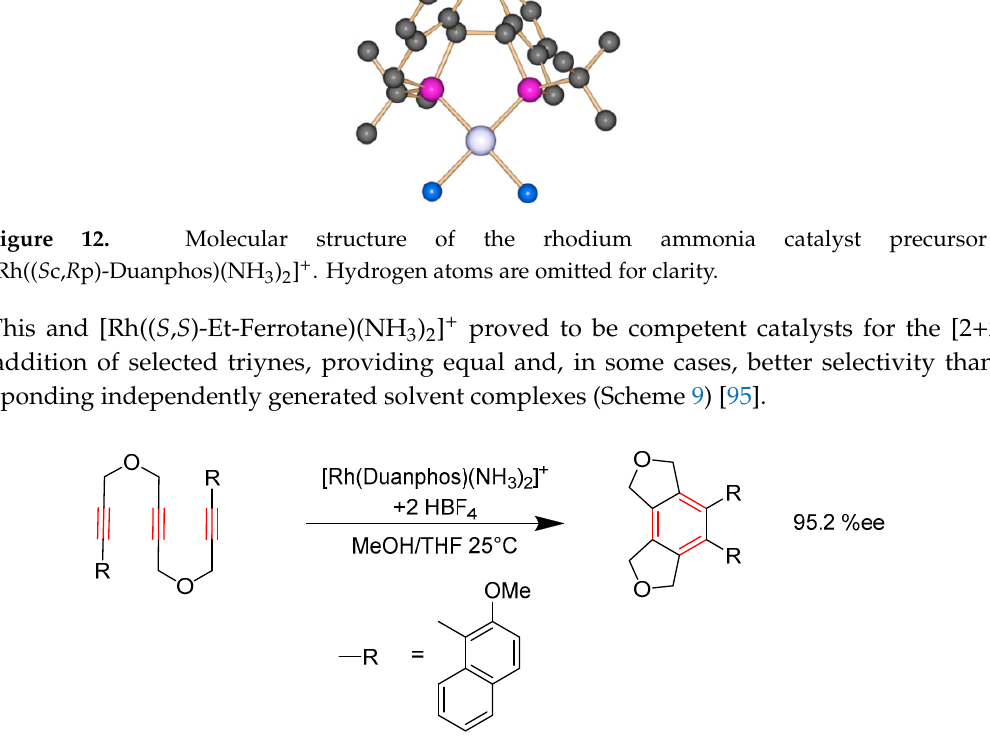
Figure11. 31 PNMRspectrumofthesolutionobtainedfollowinghydrogenationof[Rh(Me-BPE)(COD)] + Figure 11. 31 P NMR spectrum of the solution obtained following hydrogenation of [Rh(Me- in MeOH- d 4 at 25 ◦ C under 1 bar total pressure [123]. BPE)(COD)] + in MeOH- d 4 at 25 °C under 1 bar total pressure [123].